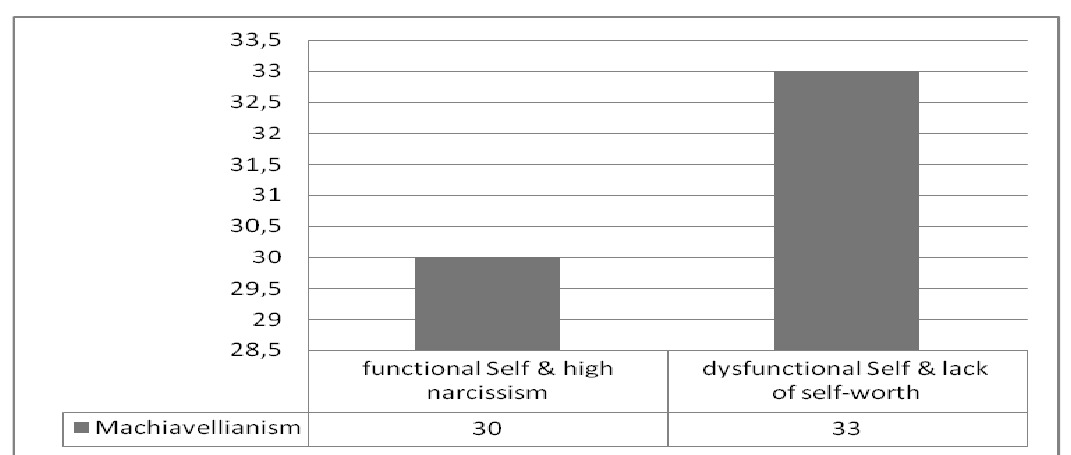
The propensity for Machiavellianism, depending on the type of narcissistic